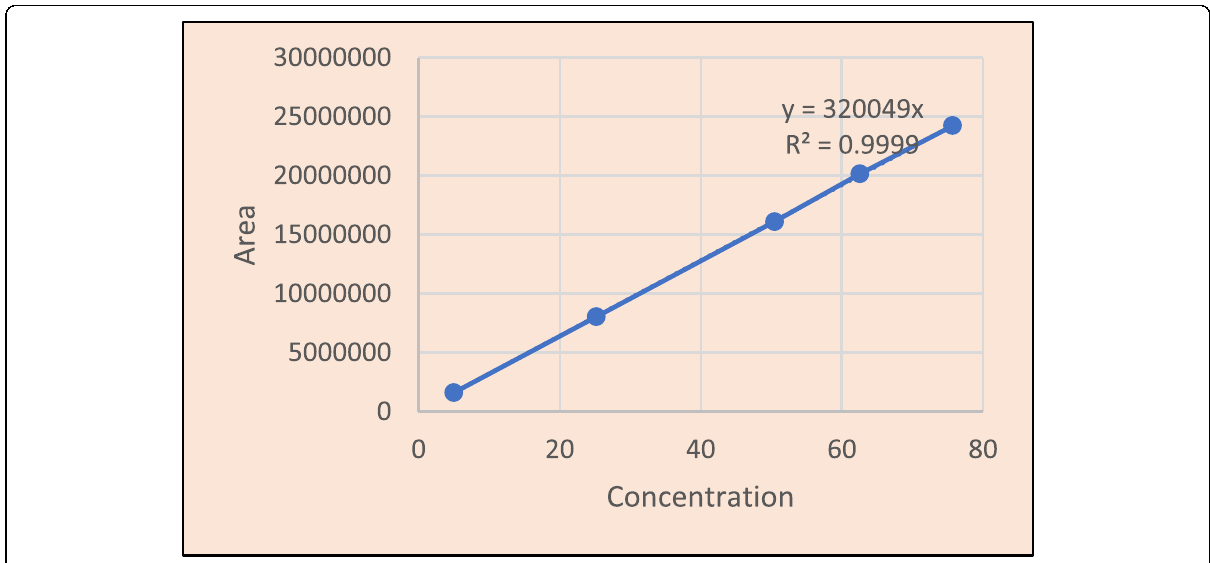
Fig. 11 Calibration curve of brexpiprazole for LOD and